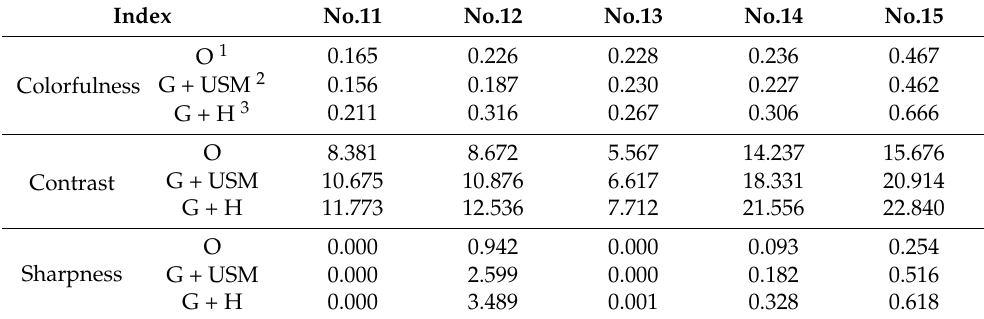
Table 5. Objective evaluation values of the five Gaussian images after the USM sharpening and the adaptive color adjustment.